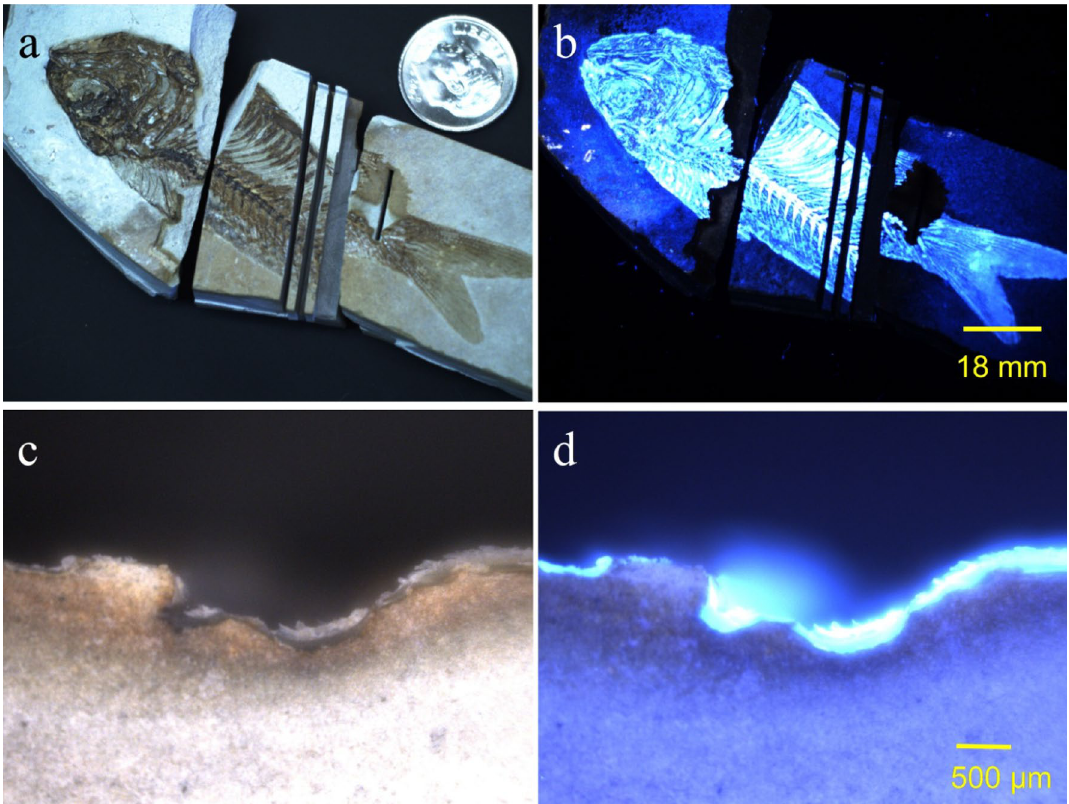
Figure 1. Biofinder detection of biological resides in fish fossil. ( a ) White light image of a Green River formation fish fossil, Knightia sp., from a distance of 50 cm using the Biofinder without laser excitation. ( b ) Fluorescence image of the fish fossil obtained by the Biofinder using a single laser pulse excitation, 1 µs detection time, and 3.6% gain on the CMOS detector. ( c ) Close-up white light image of the fish fossil cross-section using a 10× objective with 54 mm working distance showing the fish remains and rock matrix. ( d ) Fluorescence image with a single laser pulse excitation showing strong bio-fluorescence from the fish